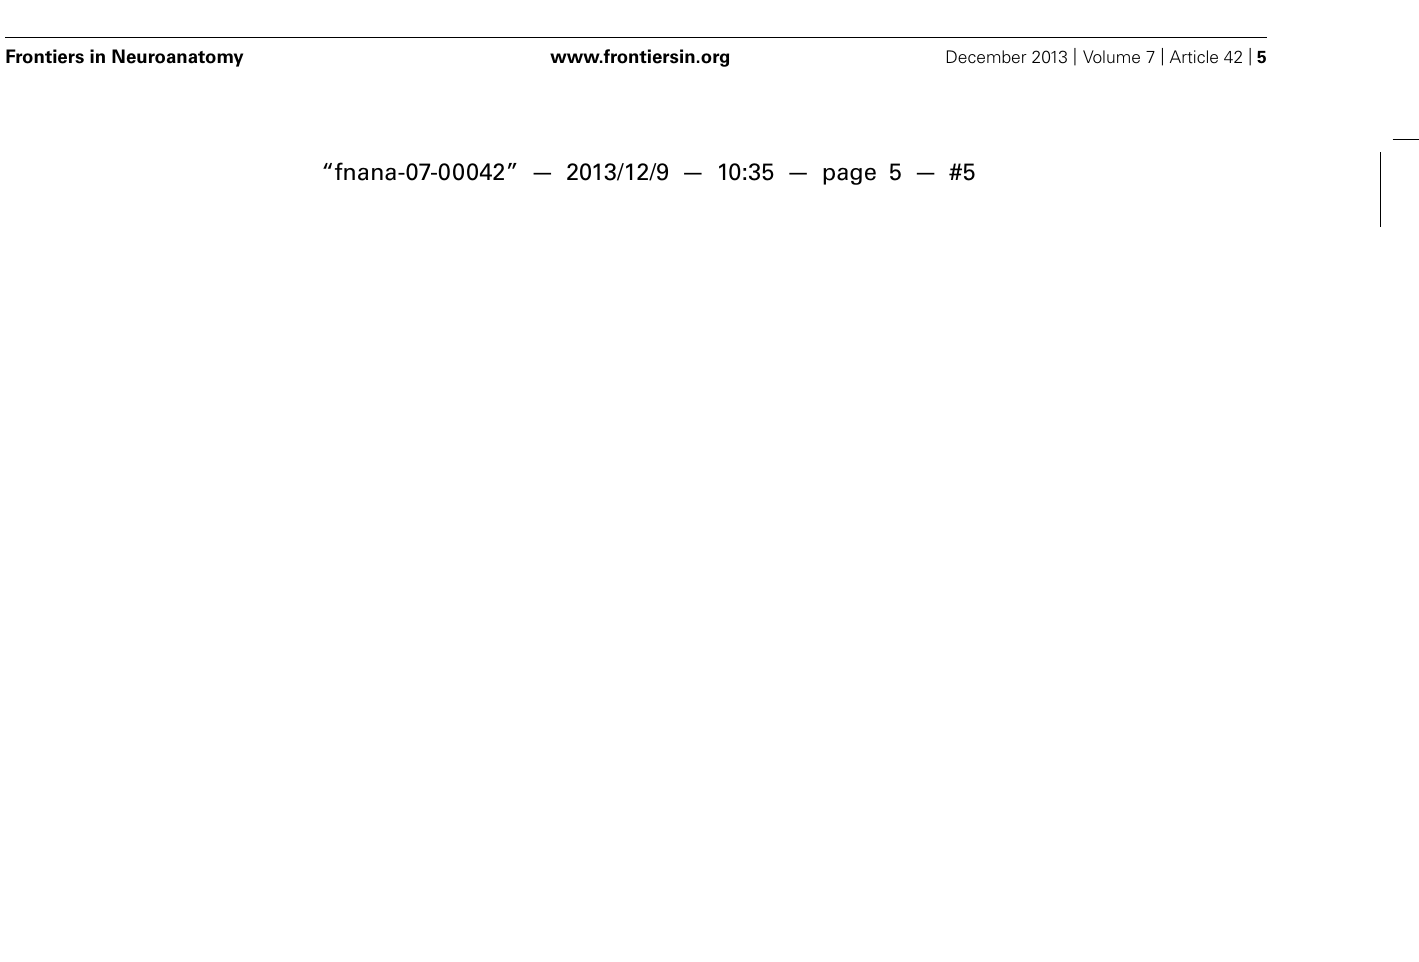
FIGURE 3 | Quantitative analysis of BrdU-positive cells (A) and the co-localization of GFP and BrdU (B) in the spinal cord of the P60 GAD 67 -GFP knock-in mice following injections of BrdU at different developmental stages. The x -axis depicts the embryonic stages in which BrdU was injected, and the y -axis depicts the number of BrdU-positive cells